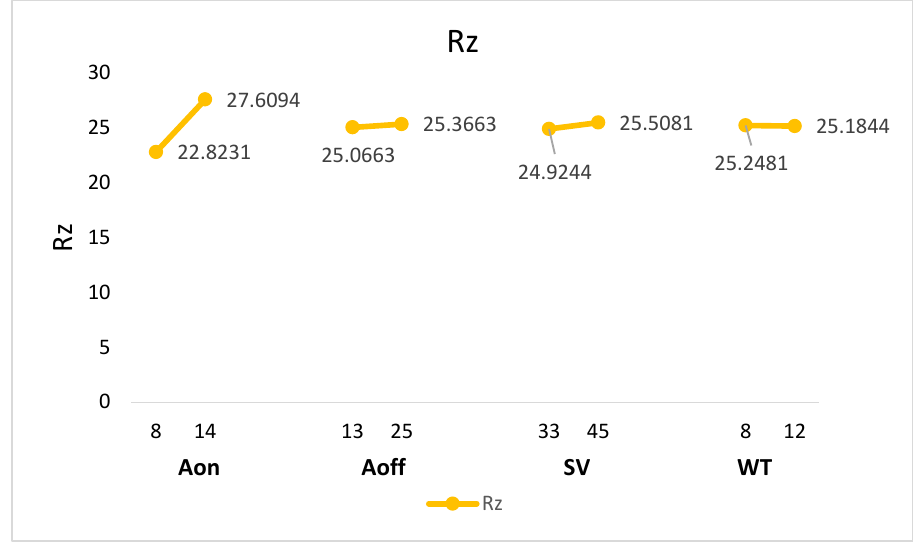
Figure 5. Summary of process parameters with respect to Rz.